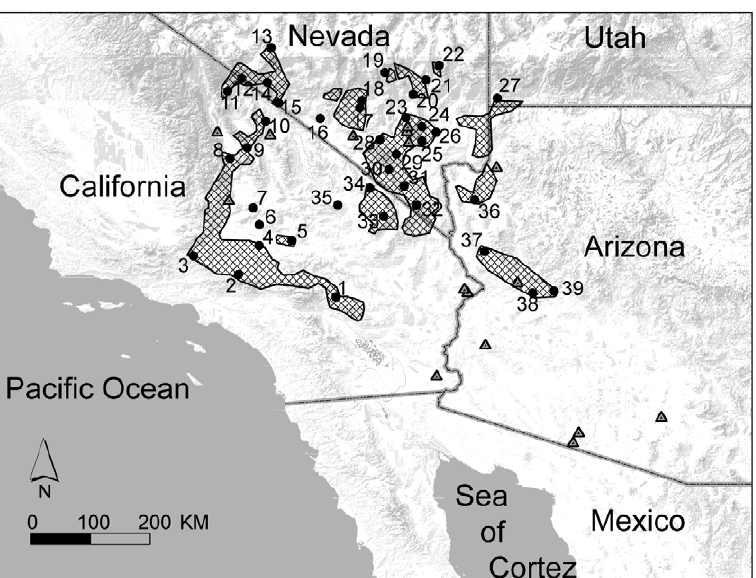
Figure 1. Study area showing the current distribution of Y.brevifolia (shaded areas), and the location of study sites (circles). The locations of 29 palaeorecords for Y. brevifolia from 13KYA or earlier are shown as grey triangles. Leaf tissue was sampled from all sites. Specimens of Prodoxus sordidus and P. weethumpi were sampled from sites 2, 13, 27, 33, and 37. Specimens of Tegeticula antithetica , which occurs in the eastern half of the range of Y. brevifolia , were collected from sites 19, 25, 27, 30, 33, and 37; specimens of T. synthetica , which occurs in the western of the range of Y. brevifolia , were collected from sites 2, 9, 11, 17, and 19.